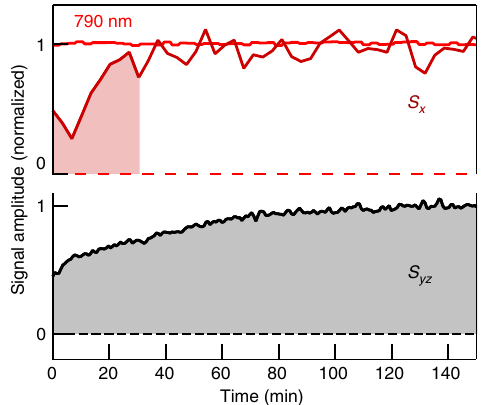
Figure 2 | Long-term signal changes. Evolution of the amplitudes of THz signals S x and S yz and the reflectance of the 790nm pump beam following cleaving of the sample. The constant 790nm signal indicates that no sample